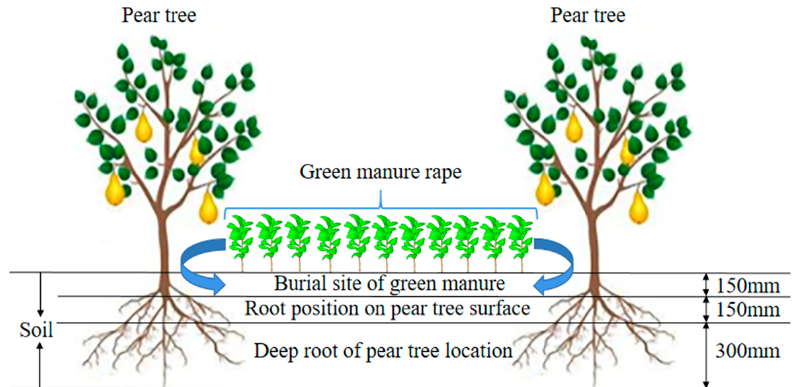
Figure 9. Green manure returning diagram in the pear garden.